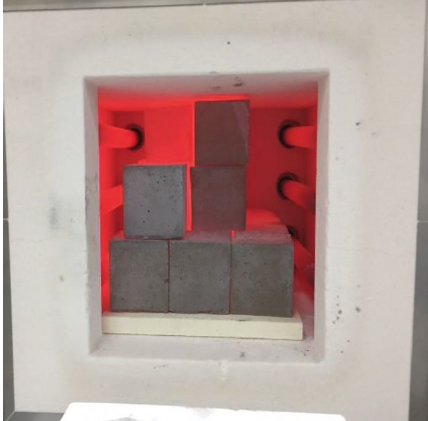
Figure 2: Mortar specimens in furnace after heat